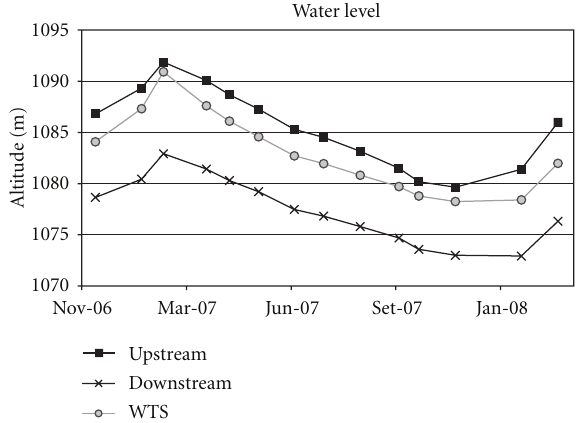
Figure 5: Variation of water levels measured in monitoring wells.